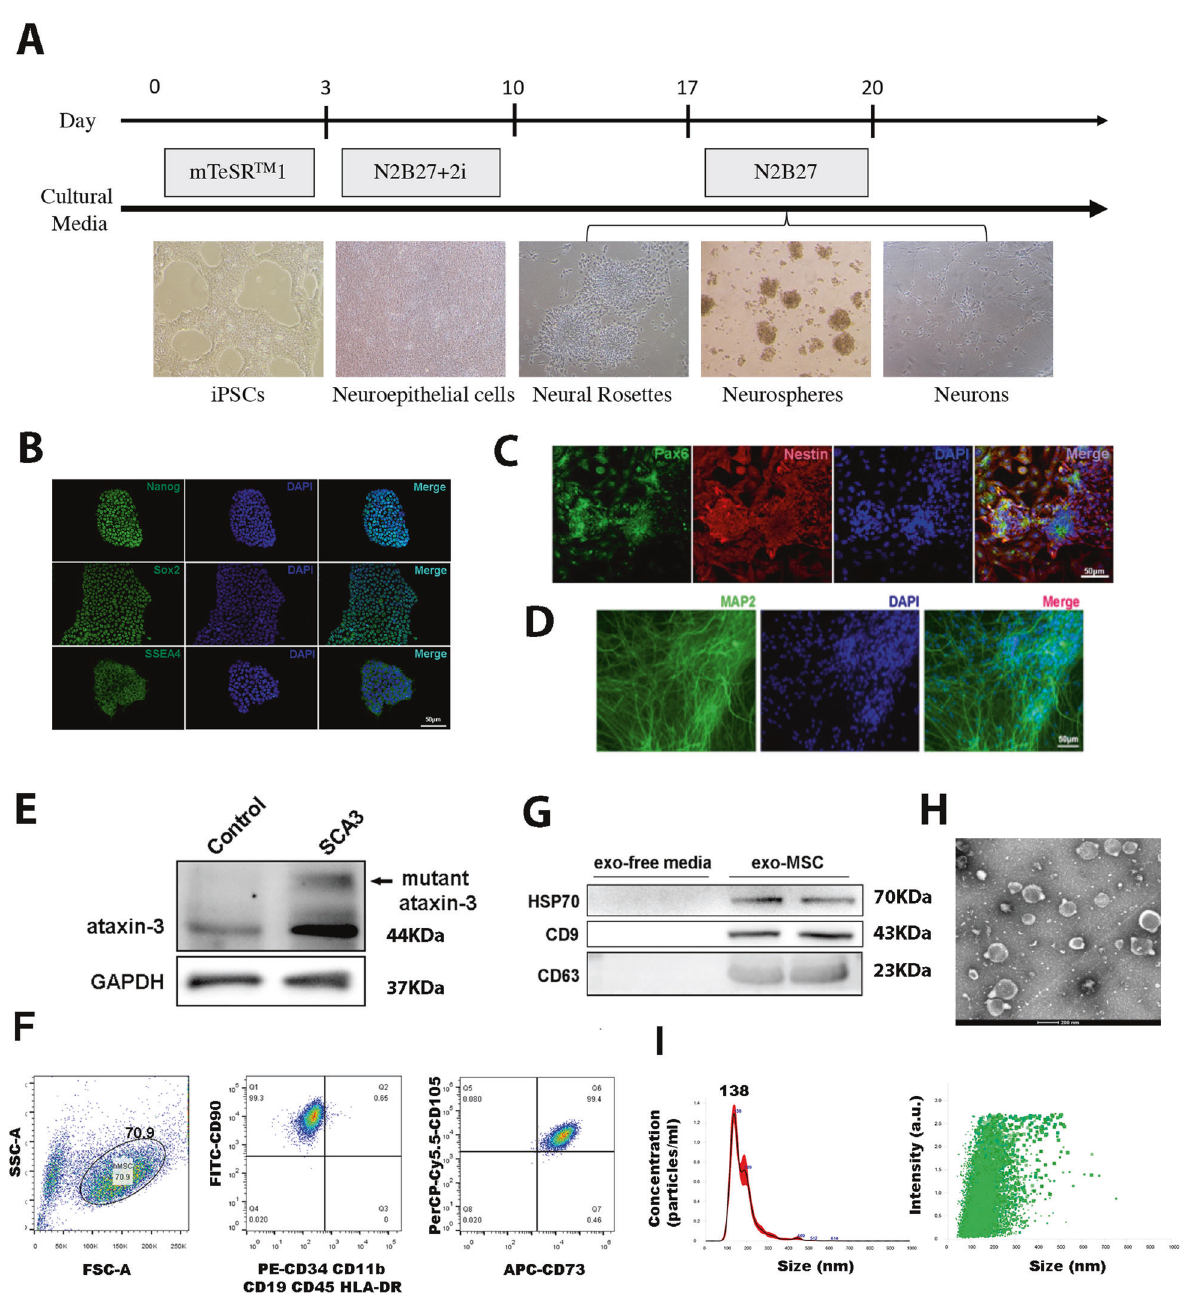
identi fi cation (scale bar: 50 μ m). D NCs related marker MAP2 analysis (scale bar: 50 μ m). E mutant Ataxin-3 protein identi fi cation in neurons. F MSCs related markers were identi fi ed by fl ow analysis, MSCs expressed highly CD90, CD107, and CD73. G Western blotting analysis of exosome-speci fi c markers CD63, CD9, and HSP70. H Transmission electron microscopy of exosomes (scale bar: 200 μ m). I Nanoparticle tracking analysis of LY294002 and AKT inhibitor Triviribine inhibited the phosphorylation of AKT and mTOR, further increasing the expression levels of LC3-II, Beclin1, and Lamp1, and decreasing the expression of p62 and mutant ataxin-3. Contrary, AMPK inhibitor Dorsomorphin inhibited AMPK phosphorylation and LC3-II, Beclin1, and Lamp1, and increased expression of p62 and mutant ataxin-3, while mTOR inhibitor LY303511 increased LC3-II, Beclin1, and Lamp1 and reduced the expression of p62 and ataxin-3. In addition, we also detected the expression of a downstream protein of the mTOR